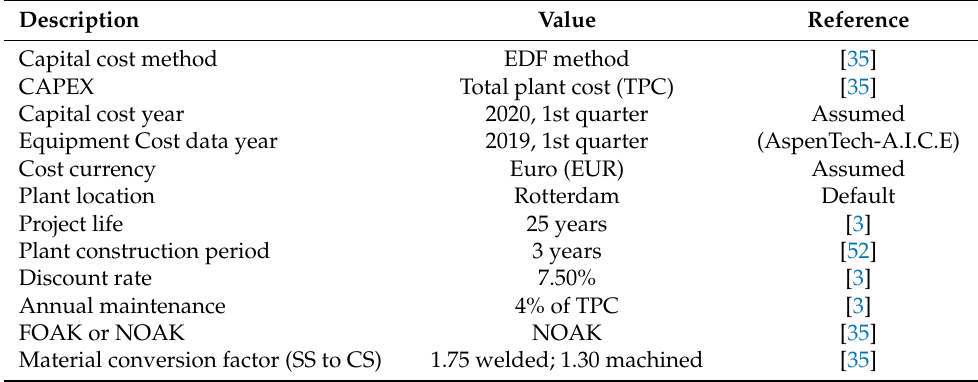
Table 3. Capital cost